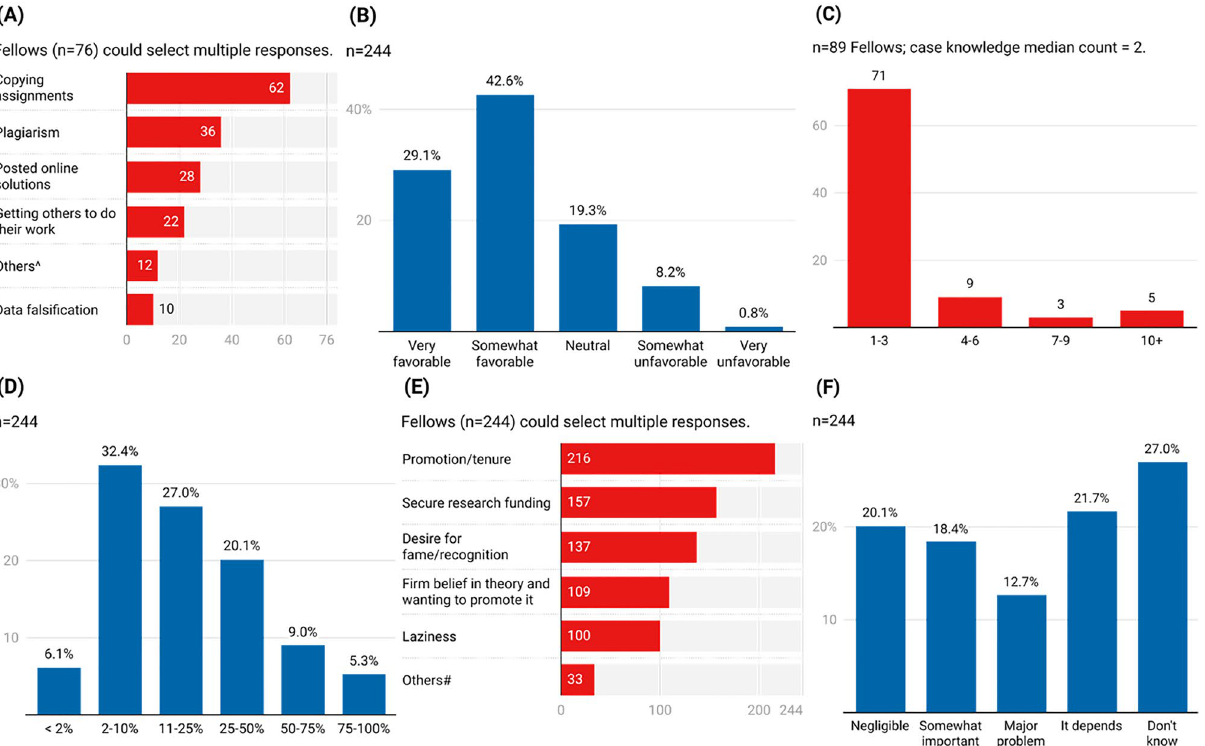
Figure 2. Academic cheating and research misconduct. ( A ) Types of cheating witnessed by NSF Fellows among graduate school peers. ( B ) Perceptions of research integrity practices based on graduate school experiences. ( C ) Histogram of research misconduct case counts Fellows reported direct knowledge of in their fields (original responses listed in Table S6). ( D ) Perceived proportion of researchers who succumb to pressures and commit misconduct at least once in their career. ( E ) Factors that contribute to misconduct or fraud. ( F ) Impact of uncovered fraud on their field. ^,# Responses under “Others” listed in Tables S4 and S6, respectively.